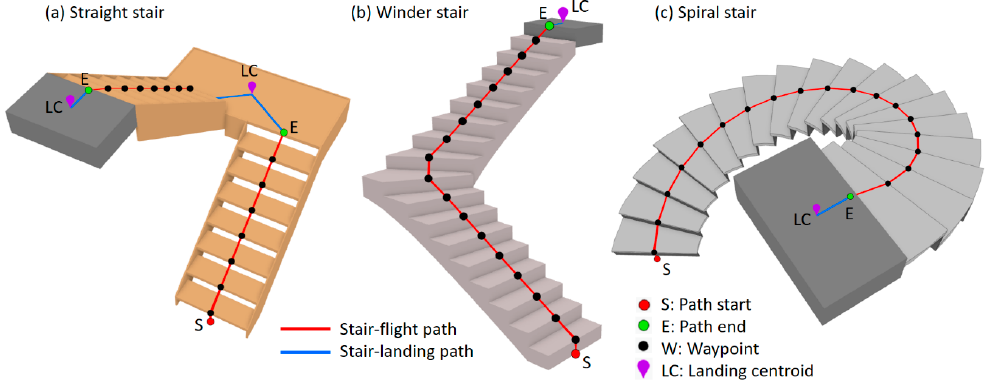
Figure 10. Overview and notations for a stair path.